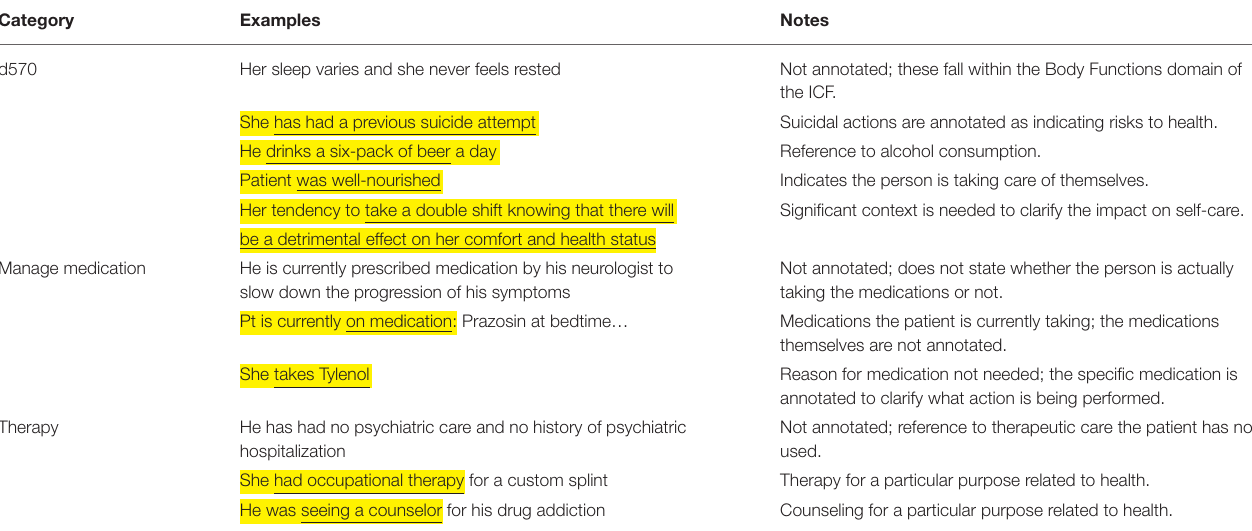
TABLE 5 | Examples for the related labels of ICF category d570, Manage Medication, and